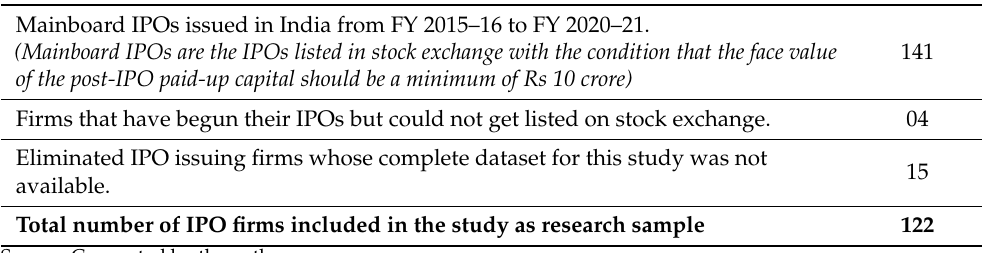
Table 1. Procedure for Selection of Sample IPO Firms.